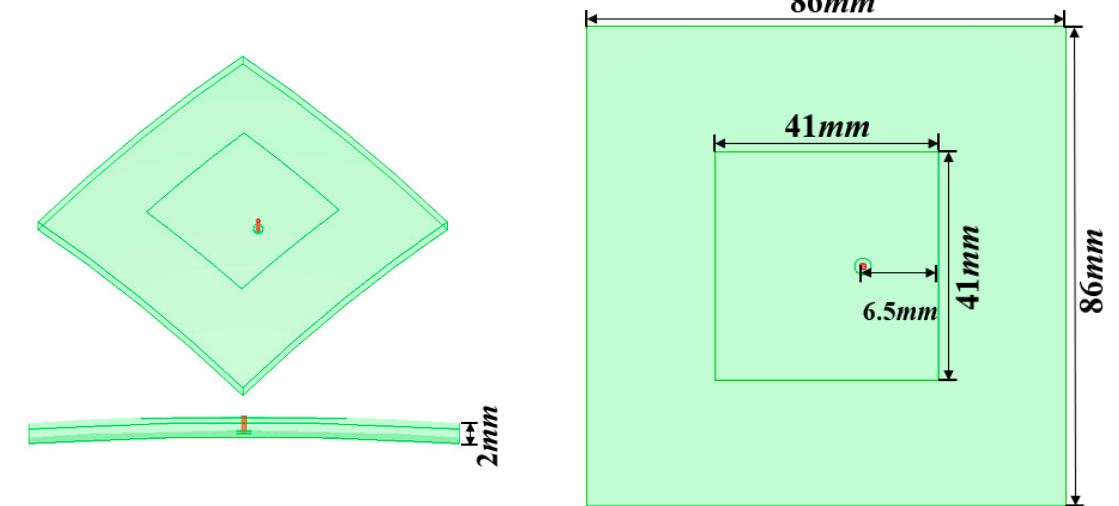
Figure 7. Model of conformal patch antenna.